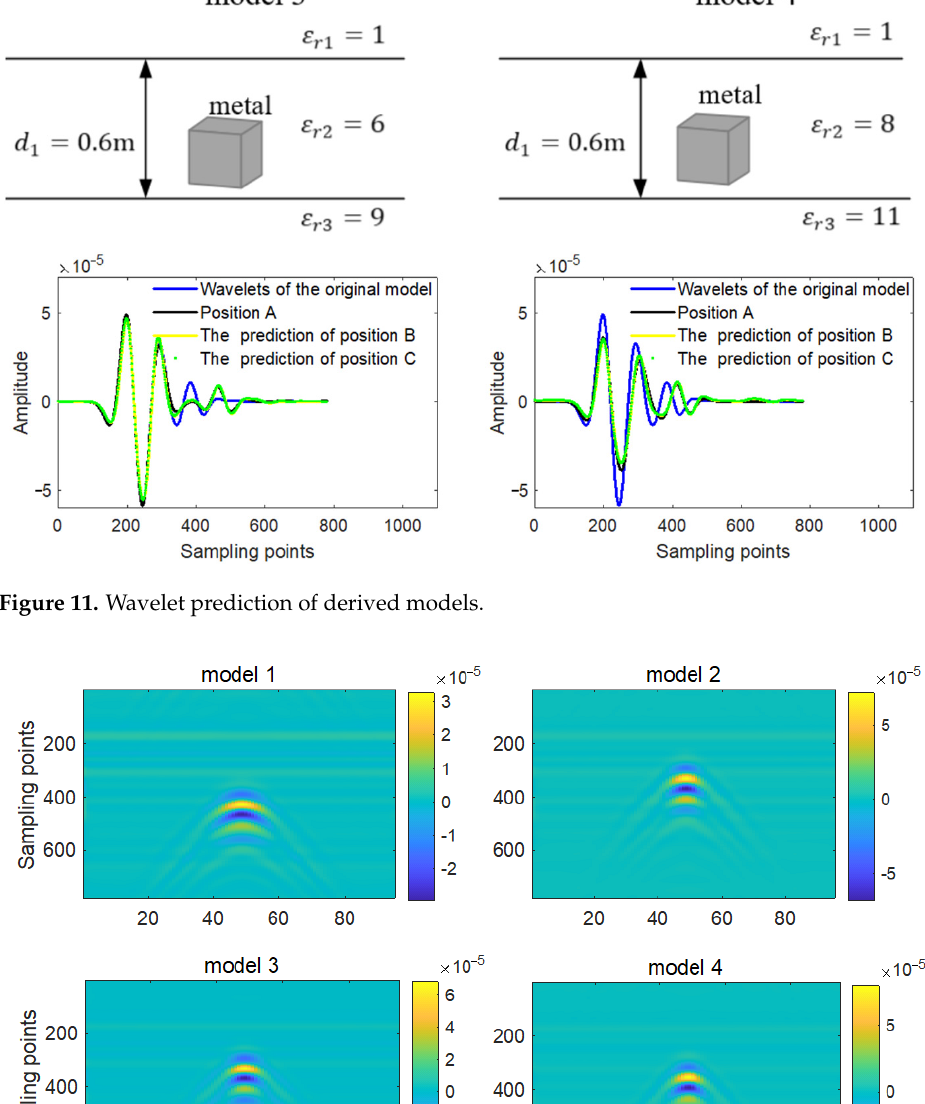
Figure 12. Predicted wavelet removal results of models 1–4.